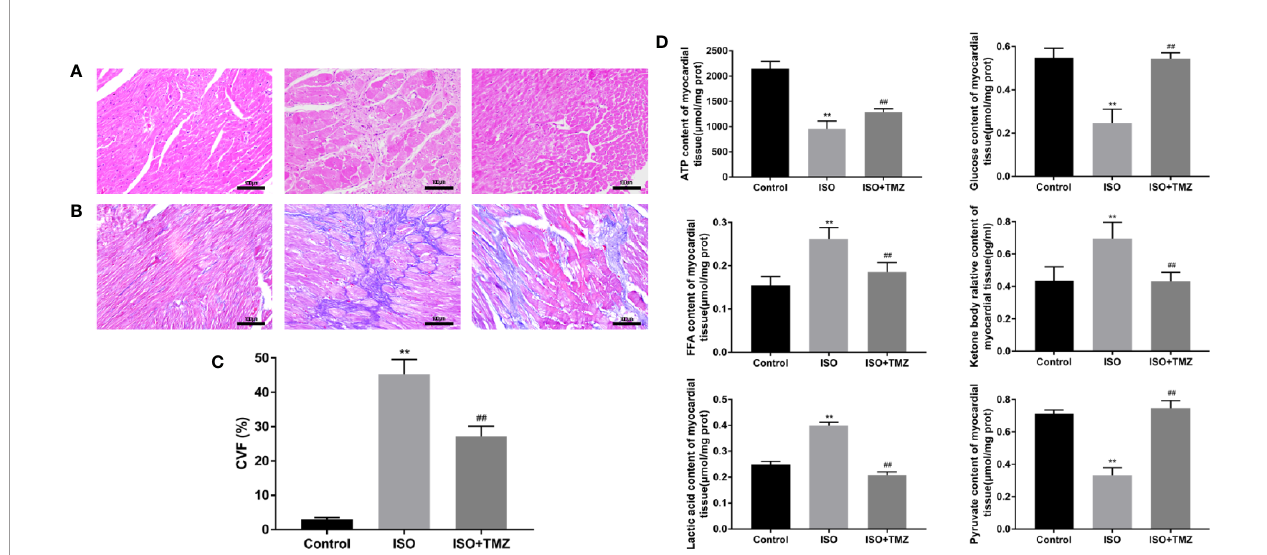
FIGURE 2 | Trimetazidine ameliorates pathological changes in myocardial tissues of isoproterenol-induced rats. (A) Histopathological changes in myocardial tissues observed by hematoxylin-eosin staining (×200 magni fi cation) (n = 5). (B) Masson ’ s Trichrome Staining of cardiac tissues (×200 magni fi cation) (n = 5). (C) The Collagen Volume Fraction of myocardial tissues was calculated as quanti fi cation (n= 5). (D) Myocardium was homogenized, and the content of ATP, glucose, free fatty acid, ketone body, lactic acid, and pyruvate were detected following the instructions (n = 6). Data were represented as mean ± SD, ## P < 0.01 compared with ISO group, **P < 0.01 compared with control